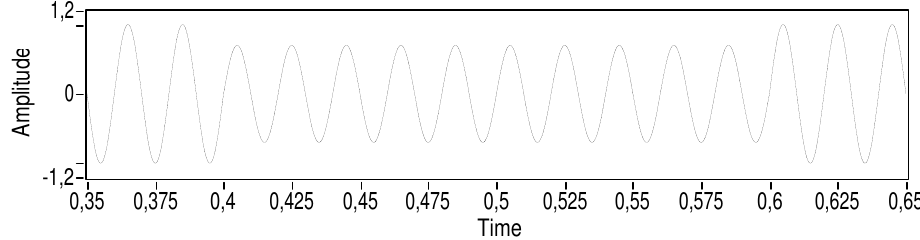
Figure 2. Sag. Time series of a sag with a depth of 30% and a duration of 10 cycles.